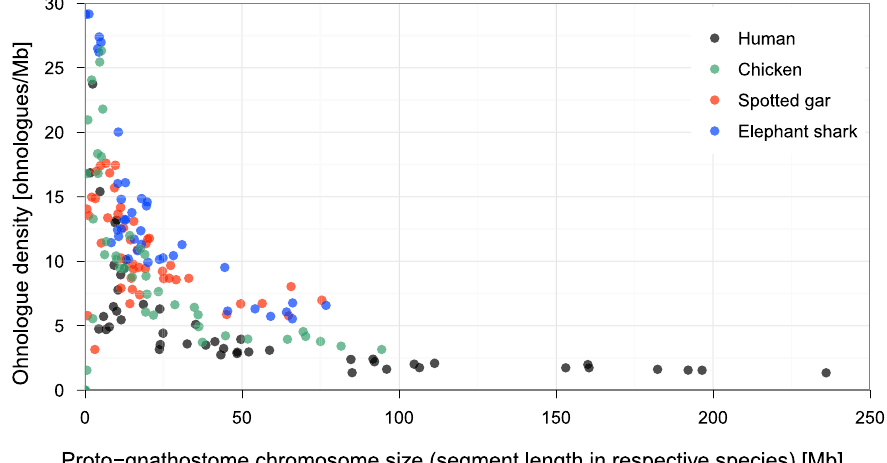
Fig. 5 Persistent conservation of chromosomal features associated with microchromosomes in gnathostomes. a Each proto-gnathostome chromosome, consisting of multiple segments, was mapped to modern genomes, and the total segment length in the human genome is shown on the x -axis, whereas the total segment length in the chicken, spotted gar and elephant shark genomes are shown on the y -axis. b Gene density (i.e., number of genes per megabase) was calculated in human, chicken, spotted gar and elephant shark segments derived from individual proto-gnathostome chromosomes. The x -axis shows the chromosome length in individual species. c Ohnologue density instead of gene density is shown on the y